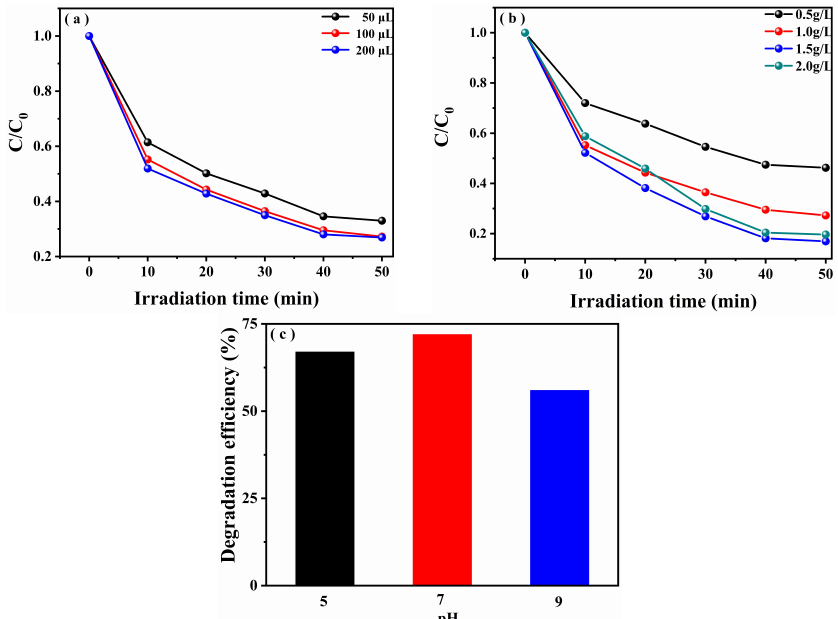
Figure 7. Effects of H 2 O 2 concentration ( a ), catalyst dosage ( b ) and initial pH value ( c ) on the photo-Fenton catalytic activity for TC-HCl removal. photo-Fenton catalytic activity for TC-HCl